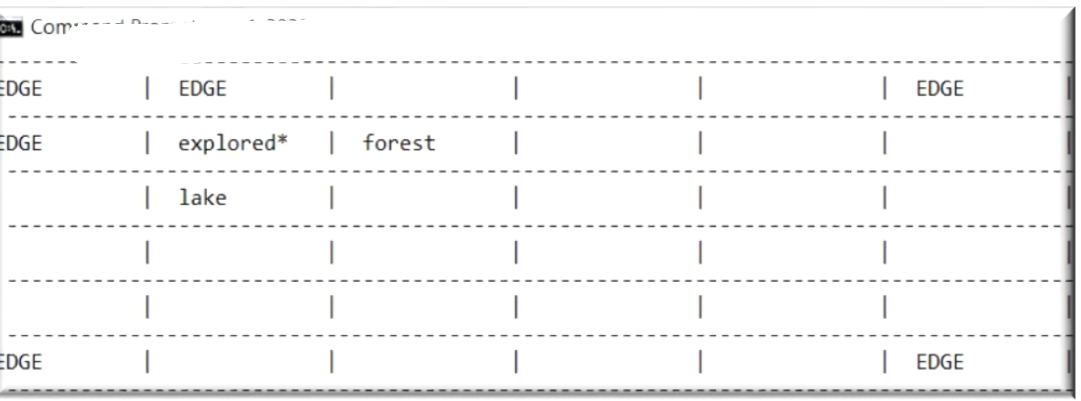
Figure 5. Internal Map which the CCA1 architecture/agent starts constructing of the external gridworld it is immersed in. * need to be